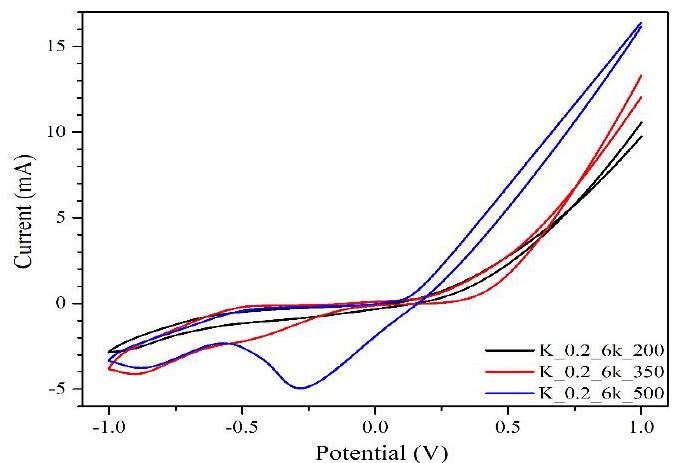
Figure 8. CV of CZTS thin films with different TT temperatures: black line, 200 °C; red line, 350 °C; and blue line, 500 °C.